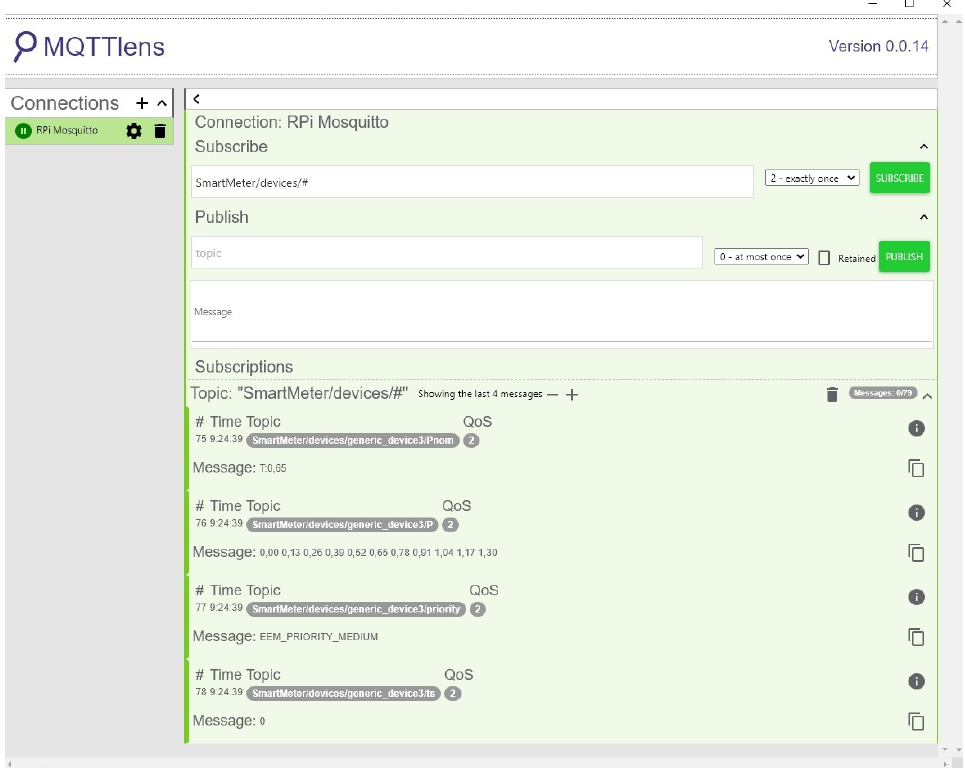
Figure 16. MQTTlens